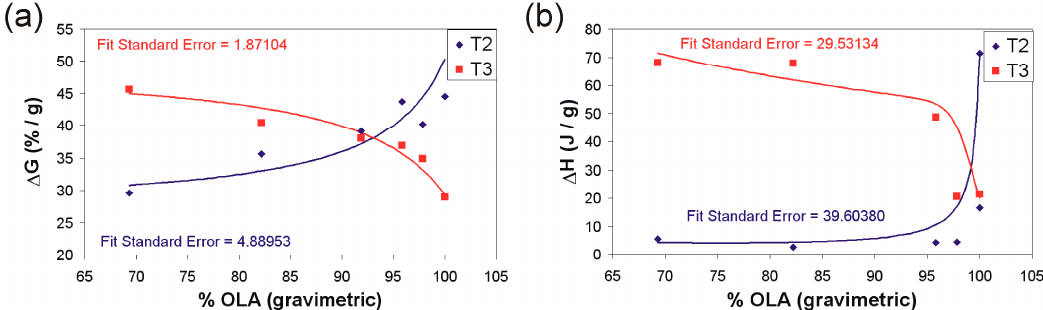
Figure 5. Evolution of ( a ) the weight loss in the 200–400 °C (T2) and respectively 400–700 °C (T3) temperature ranges and ( b ) the enthalpy corresponding to the all hybrids thermal decomposition steps (The lines are for guiding the reader. The experimental data were plotted, and the given curve was fitted with Table Curve 2D version v5.01 software. The fit standard error calculated by the software is written inside each chart).